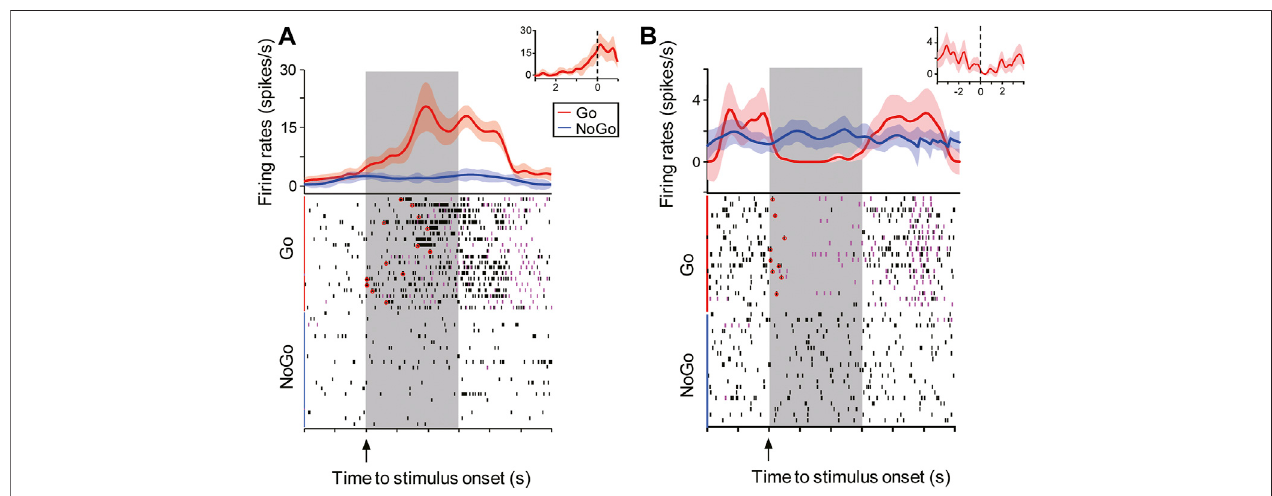
FIGURE4| Representativeexampleofanexcited andaninhibited visuomotor neuronintheNCL. Animalshad3s(grayshading)toeitherrespond(magentaticks: mandibulations) to the Go-stimulus (red line) or refrain from responding to the NoGo-stimulus (blue line). The visuomotor neurons were either excited (A) or inhibited (B) byGo-stimuli(mean±SEM),buttheydidnotrespondtotheNoGo-stimuli.TheneuronalonsettimeforeachtrialwasdeterminedbyPoissonspiketrainanalysesandare markedwithhollowredcircles intherasterplotsshowninthelowerhalf.Aftertrial-to-trial aligning allspikesofeachneurontotheanimal ’ s fi rstmandibulation(zero) during the 3 s response period, these neurons showed preceding excitatory or inhibitory activity before the animal ’ s fi rst response (insets, mean ± SEM)